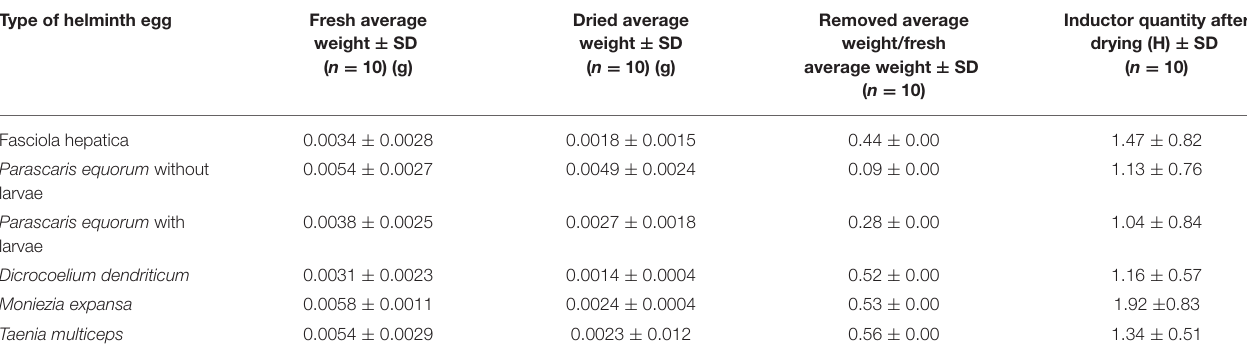
TABLE 1 | Effect of lost weight on the electrical parameter. Type of helminth